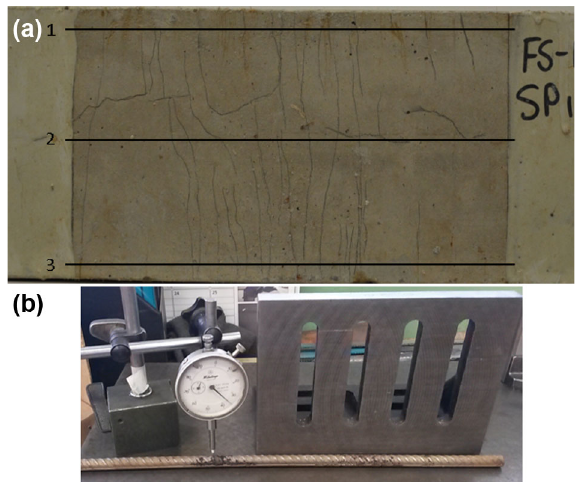
Fig. 2 a Method of determining the crack properties and b determining the pitting depths in the corroded steel